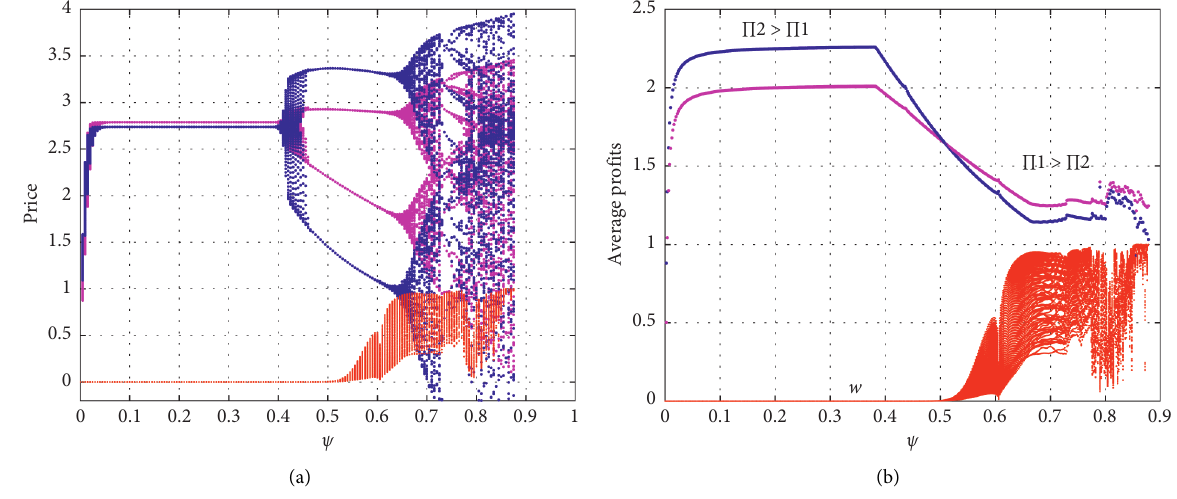
� 􏽑 in Nash equilibrium stage. 1 2